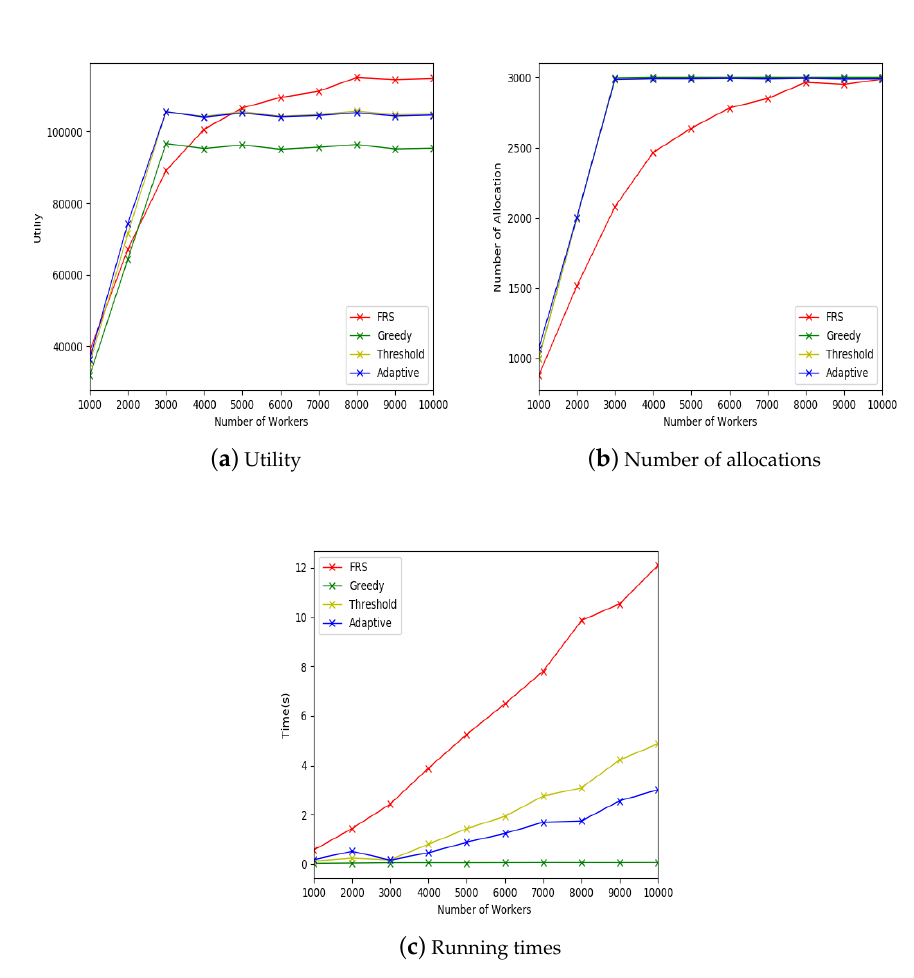
Figure 8. Effect of large-scale